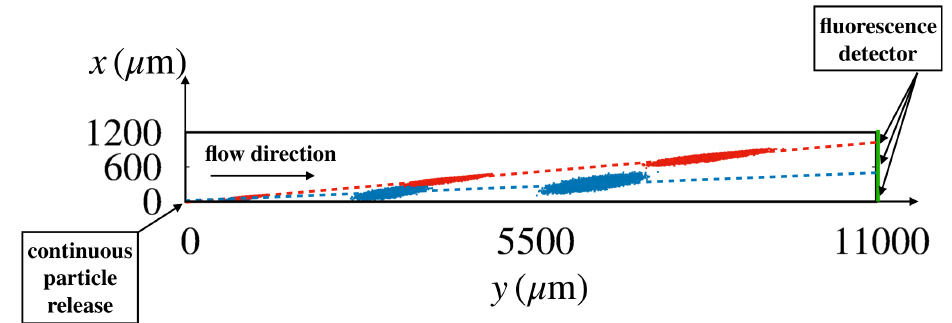
Figure 5. Snapshots of the instantaneous positions of the center of a particle released at the origin of the coordinate system for different realizations of the stochastic process Equation (2) in Huang’s device [6] at a flowrate equal to 40 µ m/s. Values of particle diffusion coefficient and flow velocity are consistent with those of the experiment (red r p = 0.45 µ m; blue r p = 0.30 µ m). The broken straight lines connect the coordinates of the center of mass of the swarm at different times. Their slope defines the average particle migration